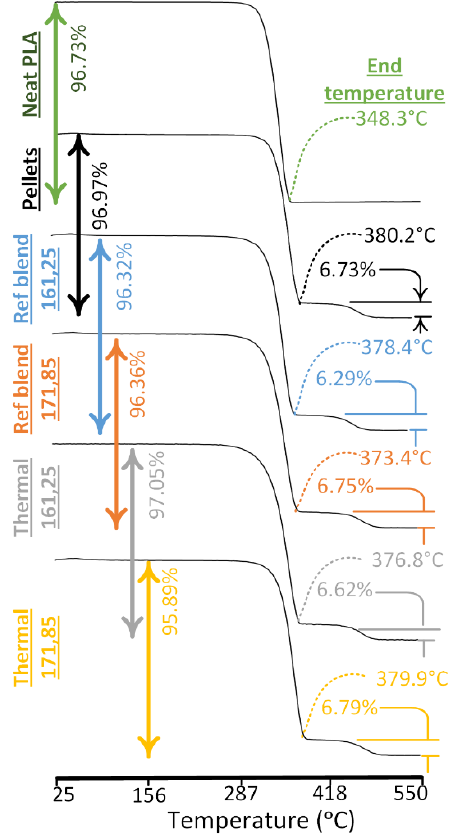
Figure 7. TGA analysis for effects of melt blending and thermal treatment (thermal aging). Thermogravimetric analysis (TGA) is performed to verify and quantify the nature of chemical interactions (grafting or physical interlocking) [12] as found in FTIR and DSC. TGA is also used to explain the stability of the novel blend against thermal degradation. Table 4. Temperature for specific mass degradation. At each specific mass loss%, negative sign shows the decrease and positive sign shows the increase of corresponding temperature as com- pared to neat PLA.